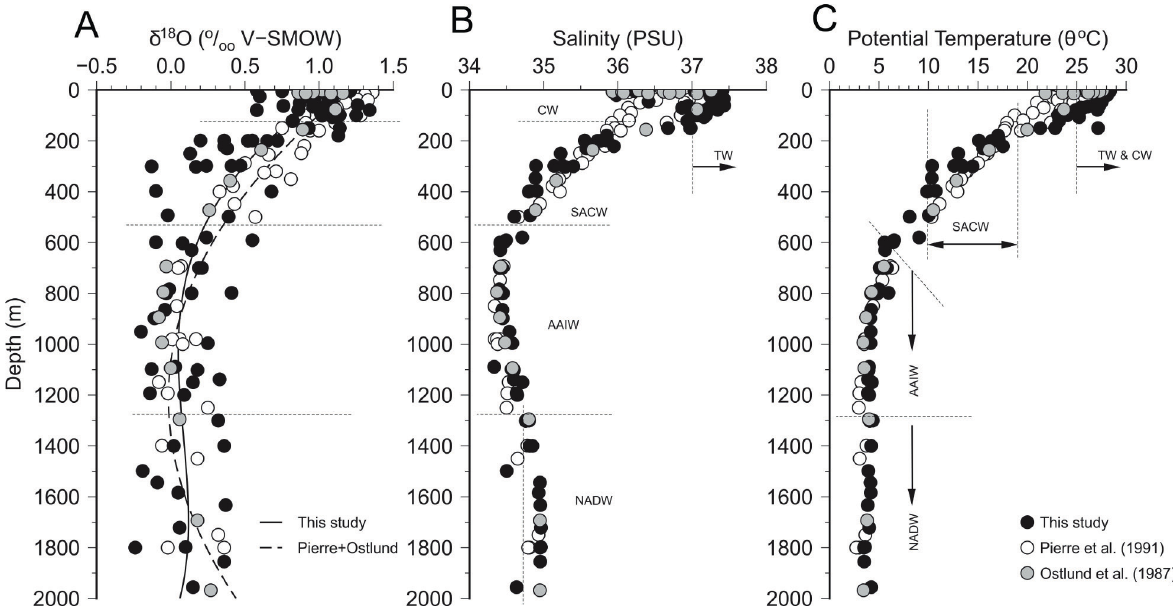
(left), salinity (middle) and potential temperature (right) compared with Pierre and sw vertical trend (3rd degree polynomial) for the present study and Pierre and sw